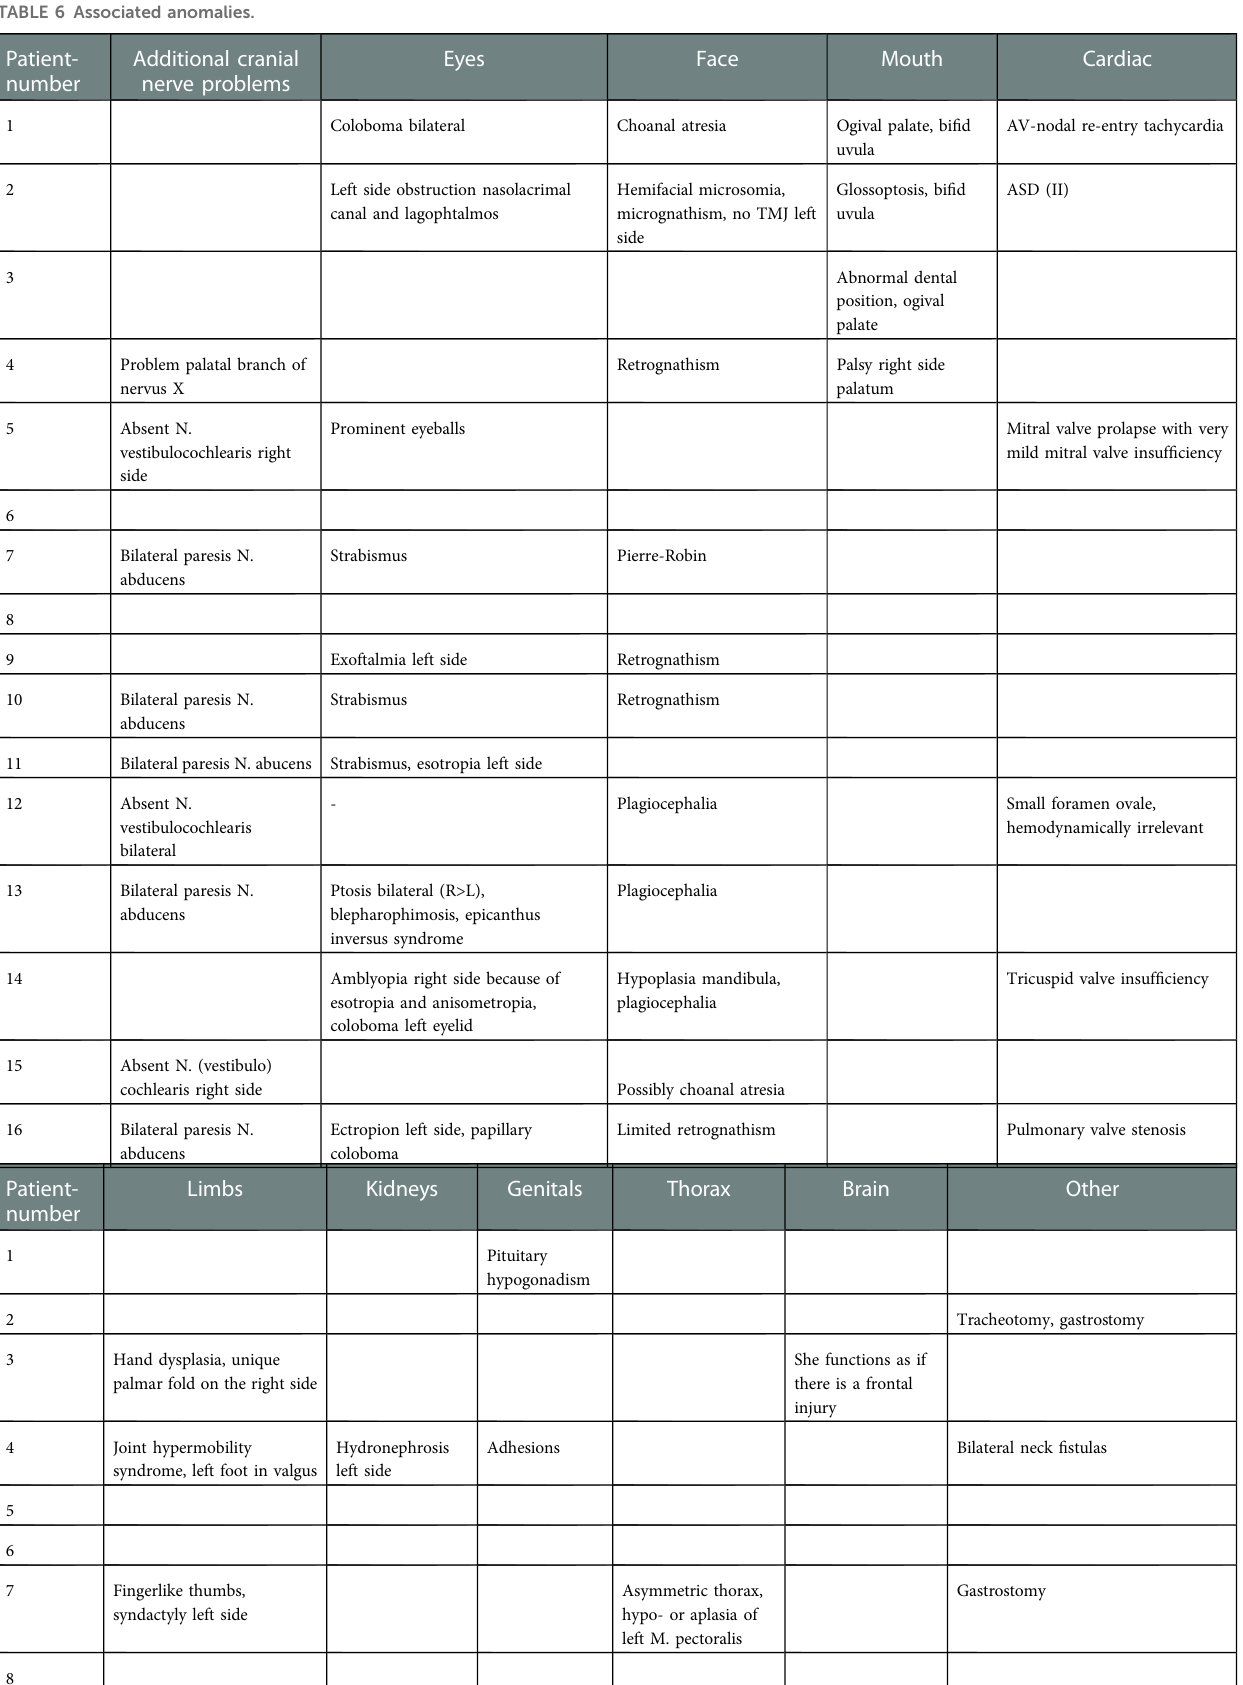
TABLE 6 Associated anomalies. Patient-